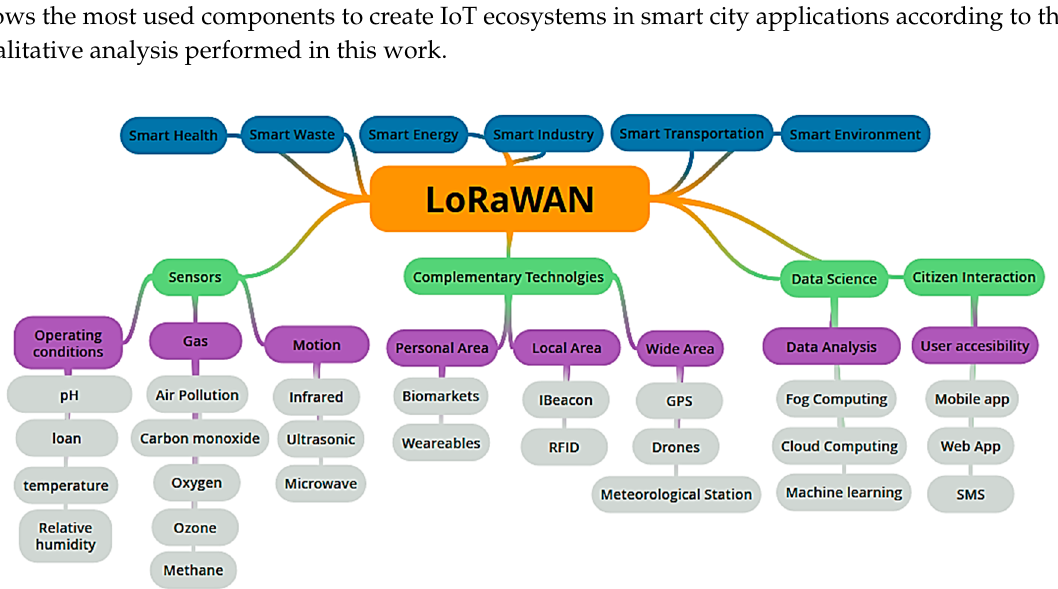
Figure 10. Types of LoRa applications in the smart city.